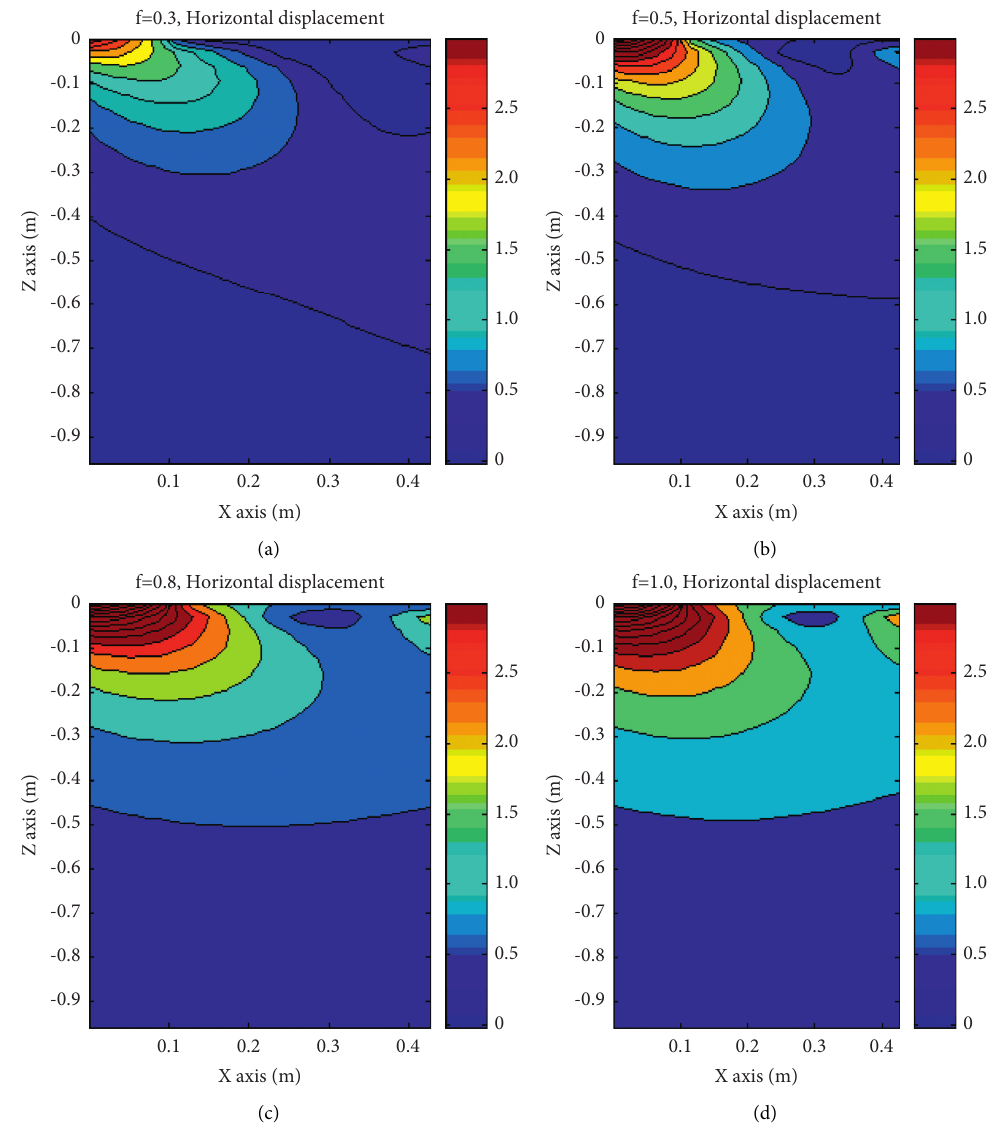
Figure 3: Horizontal displacement nephogram under different friction (f) coefficients. (a) f � 0.3. (b) f � 0.5. (c) f � 0.8. (d) f � ratio of 0.3. In the horizontal direction ( x -axis), 10 points are calculated inside the load circle, 30 points are calculated outside the load circle, and 30 points are calculated in the vertical direction ( z -axis).